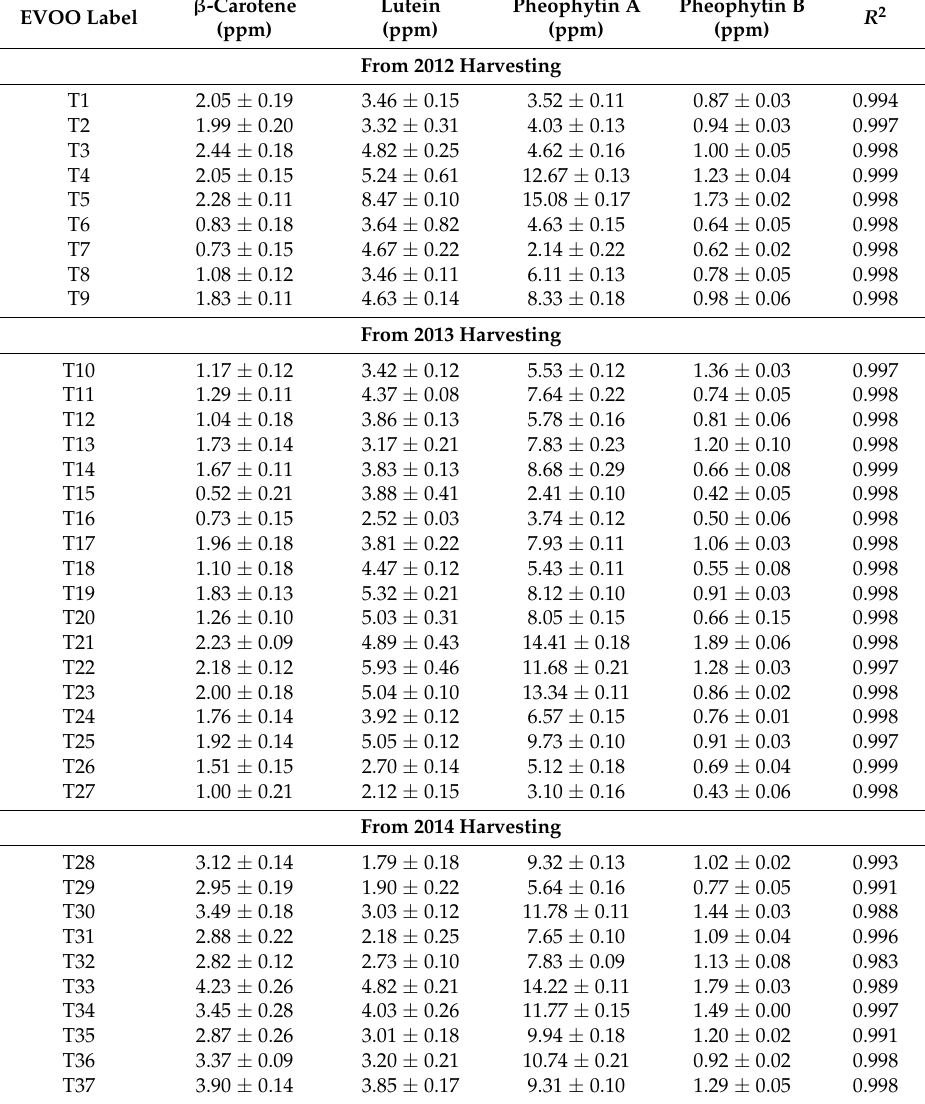
Table 1. Concentration (ppm) of the four main pigments in EVOO samples, labeled from T1 to T37, from Leccino , Moraiolo , and Frantoio cultivars produced in different years in Tuscany. Data are obtained from the analysis of the near UV-vis absorption spectra. The concentration of pigments is expressed as average value ± standard deviation (three replicates each). The coefficient R 2 of the fitting is reported for each